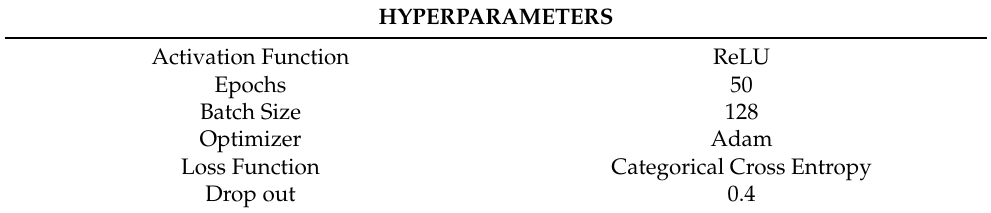
Table 1. Hyperparameters of the proposed